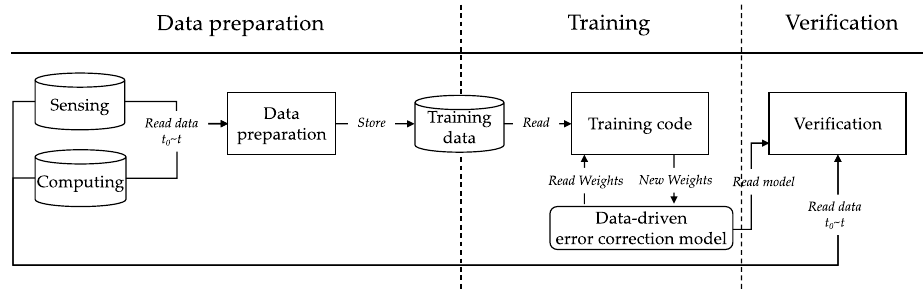
Figure 4. The working procedure of model update FE.